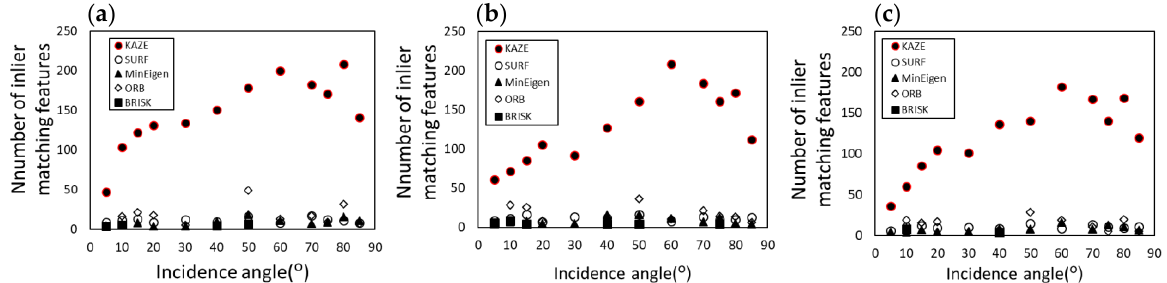
Figure 6. Number of inlier matching features of five feature matching methods. ( a ) Facing displace- ment; ( b ) Settlement; ( c ) Combined displacement.